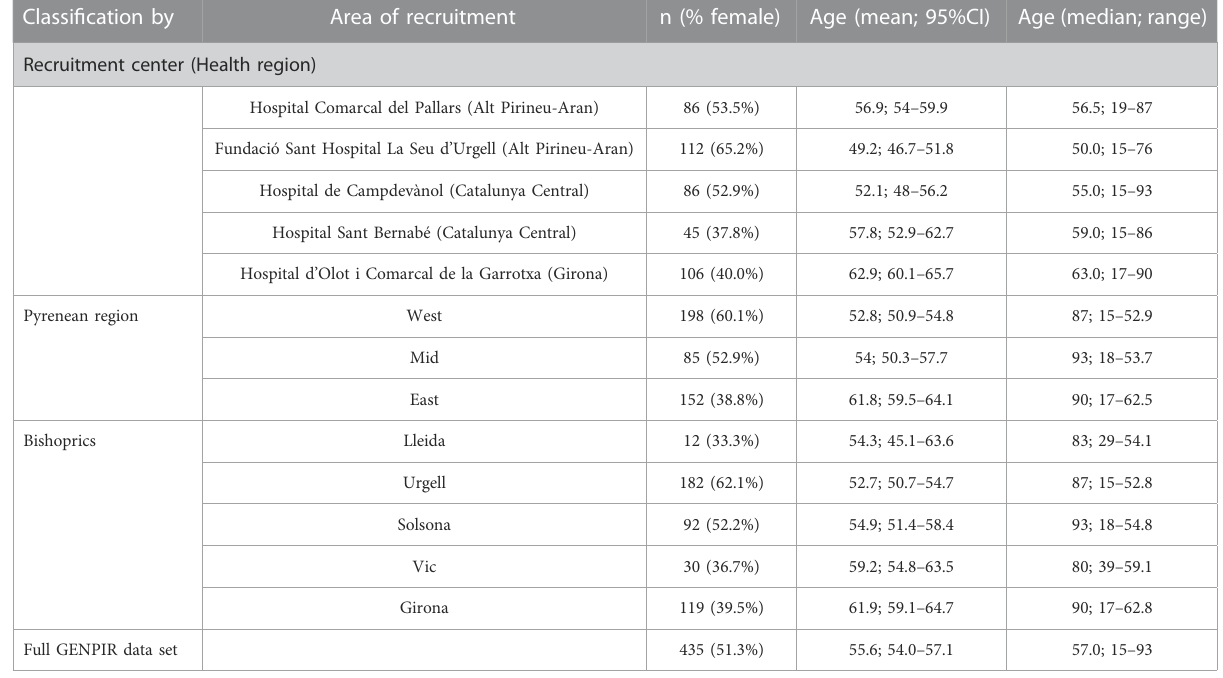
TABLE 1 Distribution of samples according to recruitment center, region and bishopric. Classi fi cation